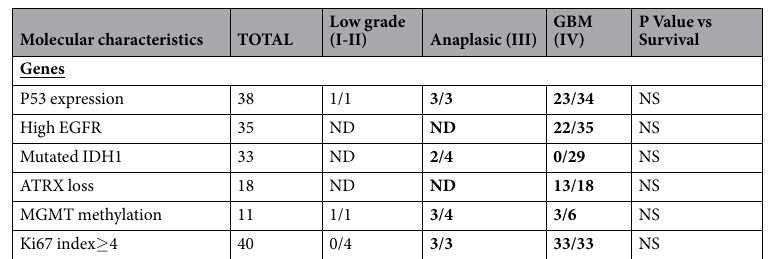
Table 2. Molecular characteristics of the glioblastoma cohort from Donostia